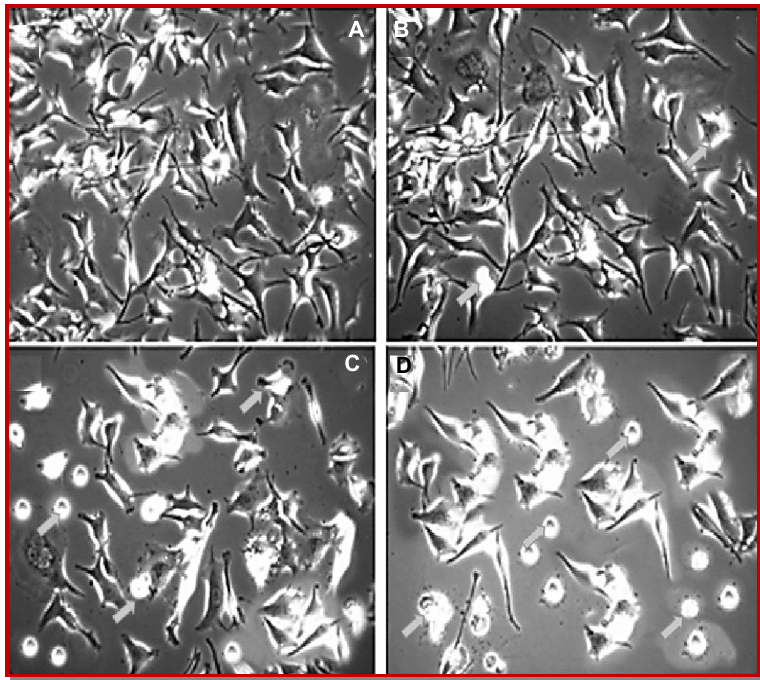
Figure 5: Triazolyl derivative of beta-bisabolol induced morphological changes in ME-180 cervical cancer cells as identified by phase contrast microscopy (magnification 200X). Rounded and contracted cells were observed in TTB-treated cells. A, represents control (untreated cells), B, C and D represent effect of 9, 36 and 72 µM of triazolyl derivative of beta-bisabolol on cell morphology of ME-180 cells